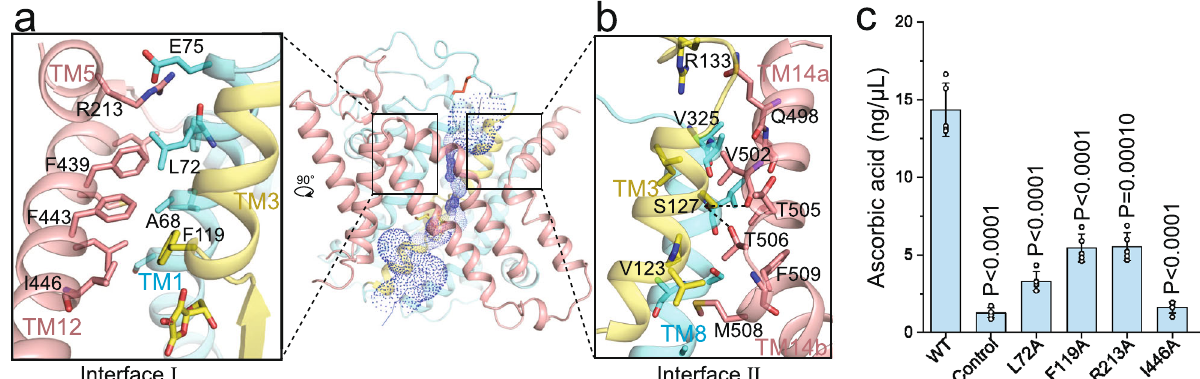
variants with point mutations at the extracellular interface. Data points are the mean±SEM( n =5independentexperiments). P valuesfromthetwo-tailed t -testare indicated on the bar chart. Source data are provided as a Source Data fi le.